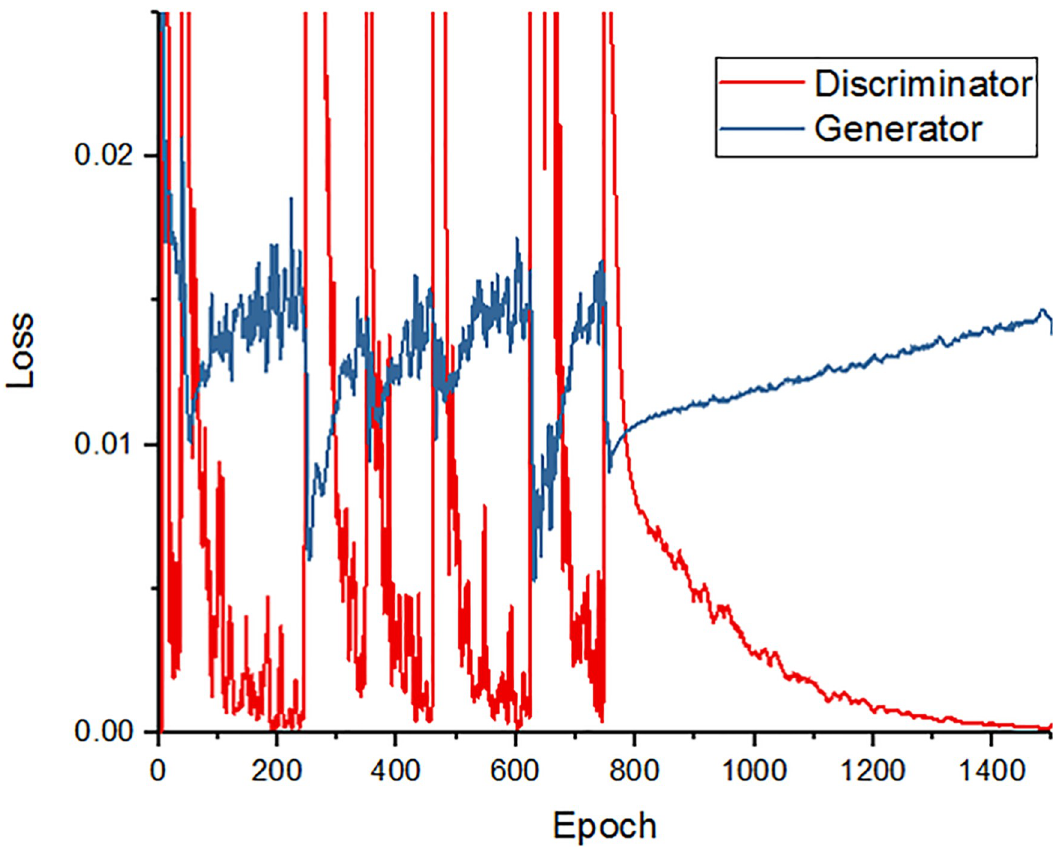
Fig 5. Training curve for deep-learning algorithm. The red line shows the accuracy of the discriminator over the training course, while the blue line represents the accuracy of the generator. As can be seen, after the 800th epoch, the discriminator’s loss decreases and the generator’s loss